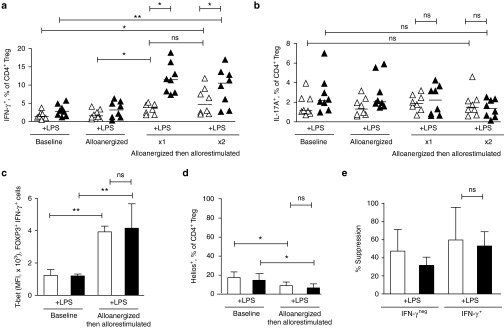
Regulatory T-cells (Treg) expanded after alloanergization in lipopolysaccharide (LPS)-rich conditions are enriched with allosuppressive IFN-γ-secreting cells. (a) Frequencies of IFN-γ+ cells expressed as percentage of CD4+ Treg at baseline, after alloanergization and after allorestimulation in the absence or presence of LPS. Horizontal lines represent median values. P values are for two-tailed t-test. Results are shown for eight HLA-mismatched stimulator-responder pairs. *P < 0.05, **P < 0.01. (b) Frequencies of IL-17A+ cells expressed as percentage of Treg at baseline, after alloanergization and after allorestimulation. Horizontal lines represent median values. P values are for two-tailed t-test. Results are shown for eight HLA-mismatched stimulator- responder pairs. ns, not significant. (c) IFN-γ+ Treg following alloanergization and allorestimulation upregulate T-bet. Bar chart summarizes mean (±SD) median fluorescence intensity (MFI) of T-bet CD4+FOXP3+IFN-γ+ Treg at baseline and after alloanergization and allorestimulation. Results for three independent experiments are shown. P values are for two-tailed t-test. **P < 0.01, ns, not significant. (d) IFN-γ+ Treg following alloanergization and allorestimulation are predominantly heliosneg. Mean (±SD) frequencies of Helios+ cells expressed as a percentage of CD4+FOXP3+IFN-γ+ Treg at baseline and after alloanergization and subsequent allorestimulation. Results are for three independent experiments. P values are for two-tailed t-test. *P < 0.05, ns, not significant. (e) Allosuppressive capacity of IFN-γ+ and IFN-γneg Treg subpopulations after alloanergization and subsequent allorestimulation of healthy donor peripheral blood mononuclear cells (PBMCs) in the presence or absence of LPS. Mean percentage suppression (±SD) of alloproliferative responses of untreated responder cells are shown by purified Treg from allorestimulated alloanergized PBMCs at a ratio of 1:10 Treg: Responder cells. Results are from four independent HLA-mismatched stimulator-responder pairs. Ns, not significant.